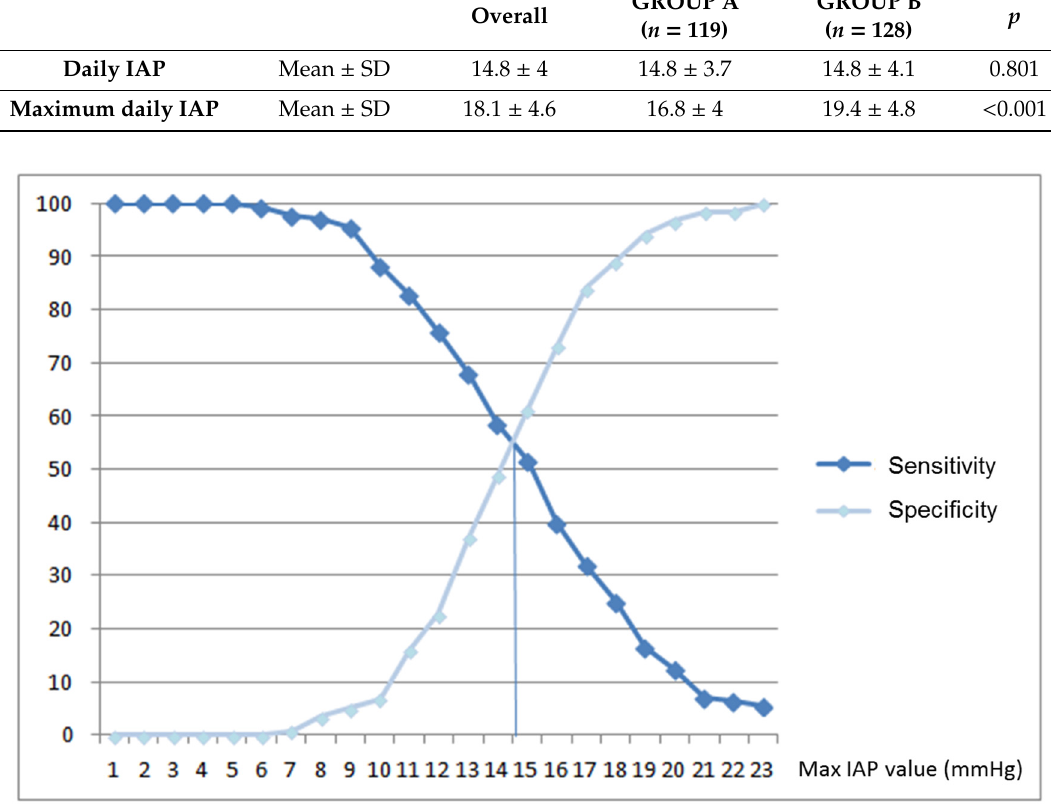
Table 3. Intra-abdominal pressure (IAP) variables recorded in critically ill, mechanically ventilated Figure 1. Receiver operating curve (ROC) of intra-abdominal pressure (IAP) recorded immediately patients without (group A) and with gastrointestinal complications (group B). before the first gastrointestinal complication in patients with gastrointestinal complications (group B) or the mean daily IAP recorded in patients without gastrointestinal complications (group A). Area under the curve = 0.595, indicating a low diagnostic power of IAP to predict gastrointestinal complications.